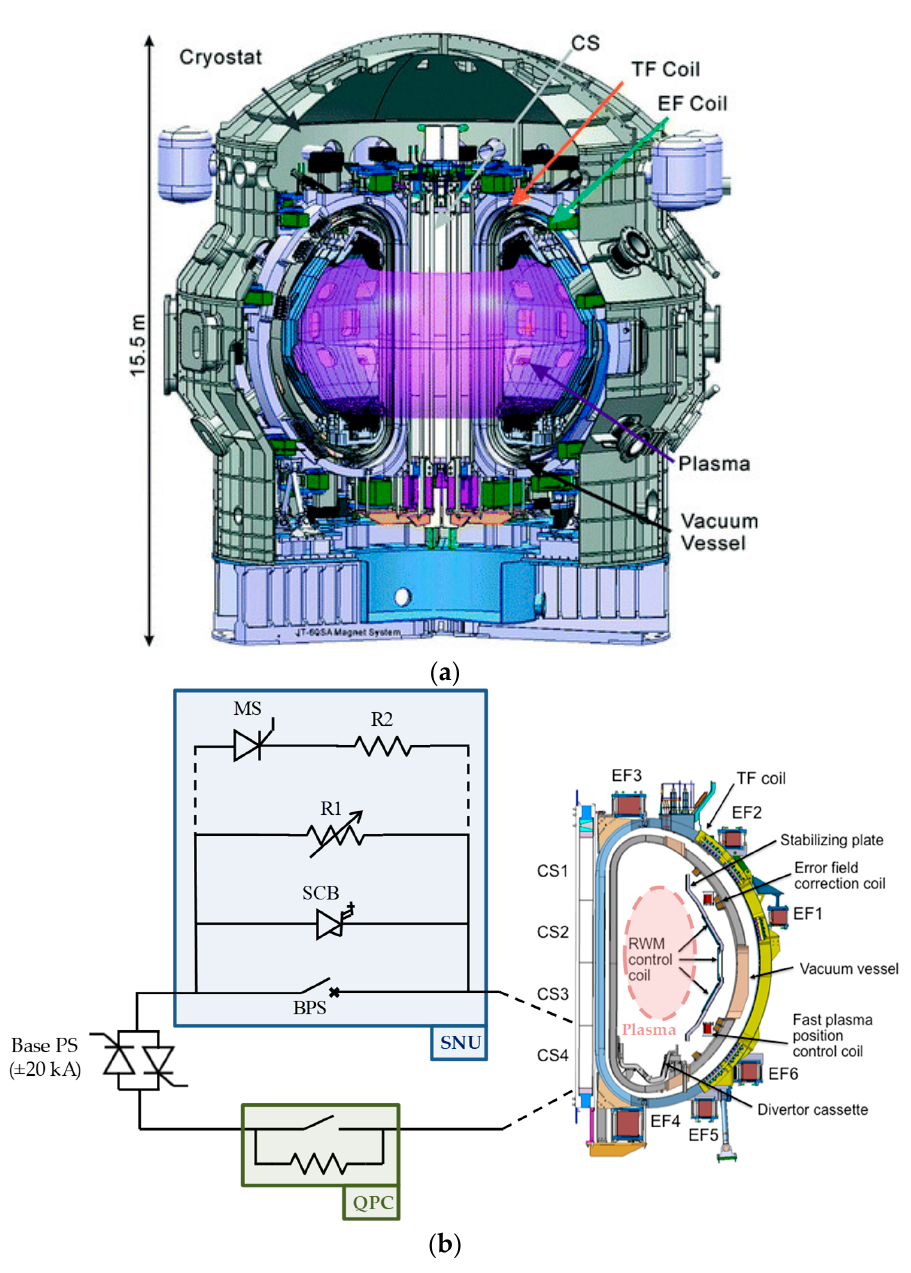
Figure 1. Information on the JT-60SA CS and related PS circuit: ( a ) Sketch of the JT-60SA tokamak with information on the position of the CS with respect to the plasma and other coils; ( b ) Simplified functional scheme of the SNU inserted in the electrical circuit of the CS4 module [8]. The other three CS modules (CS1, CS12 and CS3) are supplied by similar circuits with identical SNUs. Each CS SNU is in series with a Base PS (4-quadrant thyristor-bridge AC/DC converter) and with a QPC (for safe discharge of the energy stored in the superconducting coils).